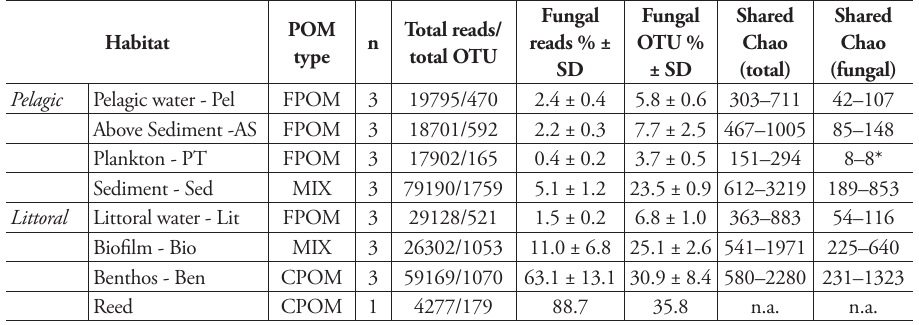
Table 1. Overview of the total abundance of eukaryotic sequences and OTUs (97% similarity clustering) recovered for each lake habitat. Fungal contribution (reads, OTUs) was calculated as median percentage with standard deviation. Habitat abbreviations used in Figs 2 and 3 are indicated to the right of habitat names. POM mainly consisted of three types: fine (FPOM), coarse particulate organic matter (CPOM), or a mixture of both (MIX). Reported values were obtained from analysis of 3 samples in each habitat, ex- cept for Reed habitat which had only 1 sample. Each of these samples contained pooled DNA from three time points (April – June 2010). The shared Chao OTU richness is given as a range between a conservative and a non-conservative estimate (see Method